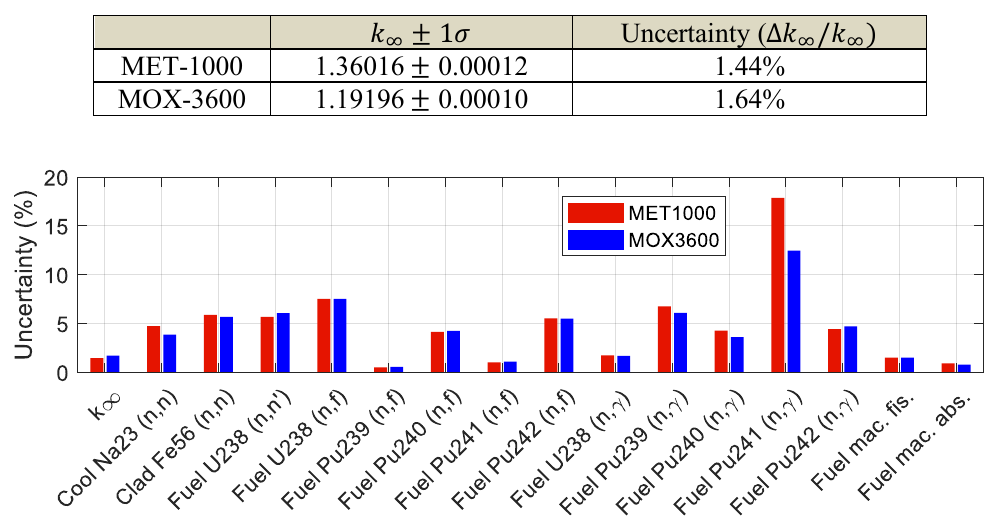
Table I. Pin-cell multiplication factor results